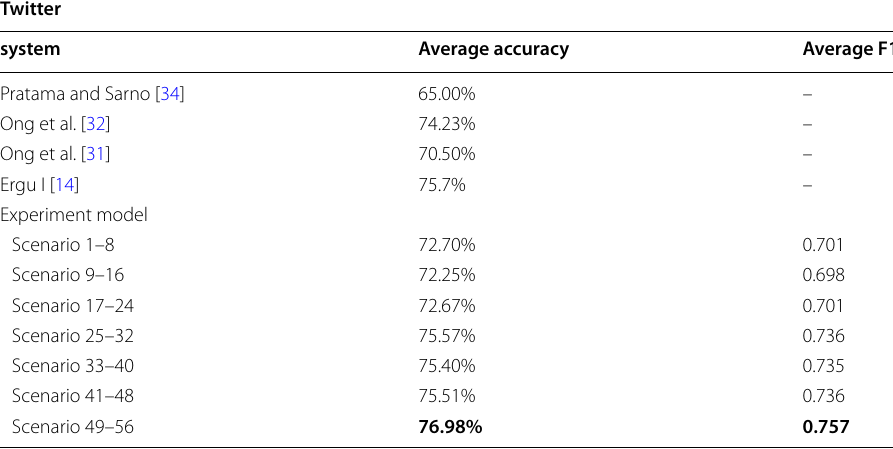
Table 11 Comparison model performance (Twitter